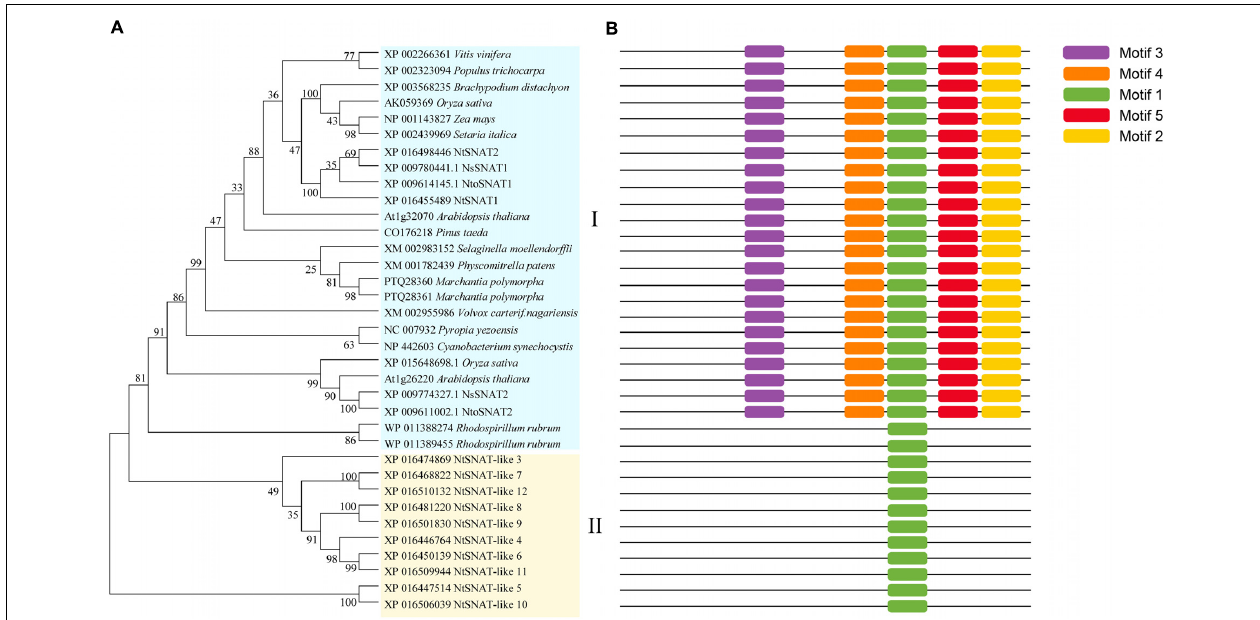
FIGURE 3 | Phylogenetic tree of NtSNAT s and other SNAT s (A) and corresponding conserved motifs for each gene (B) . Different motifs are highlighted with different colored boxes with numbers